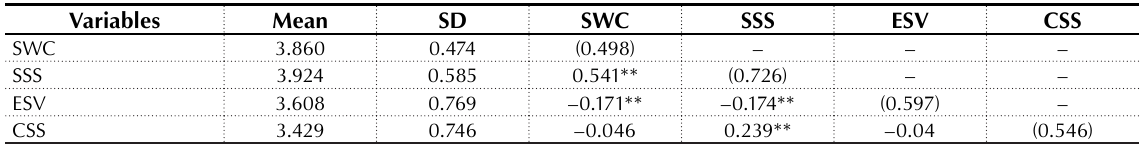
Table 1. Mean, standard deviations, Cronbach Alphas,